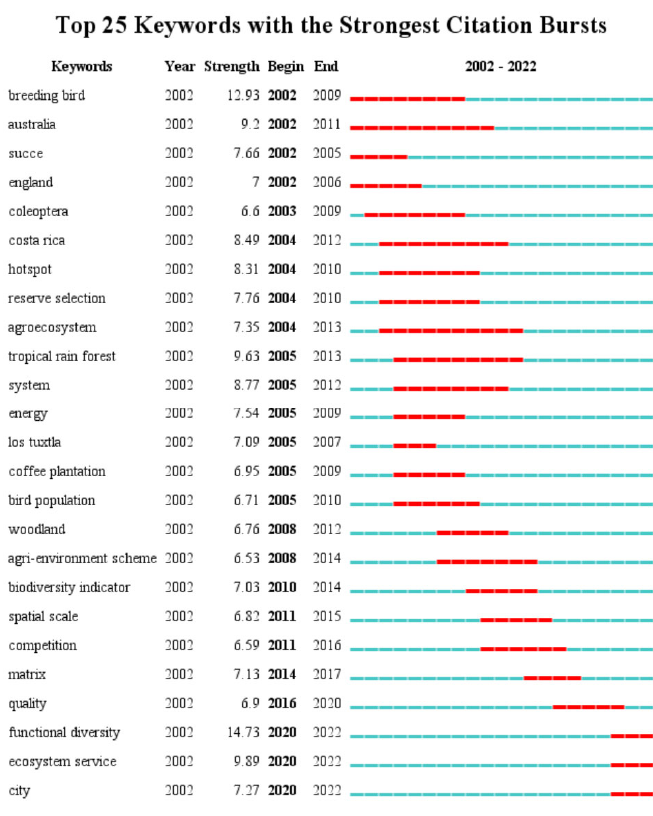
Figure 6. Top 25 keywords with the strongest citation bursts.